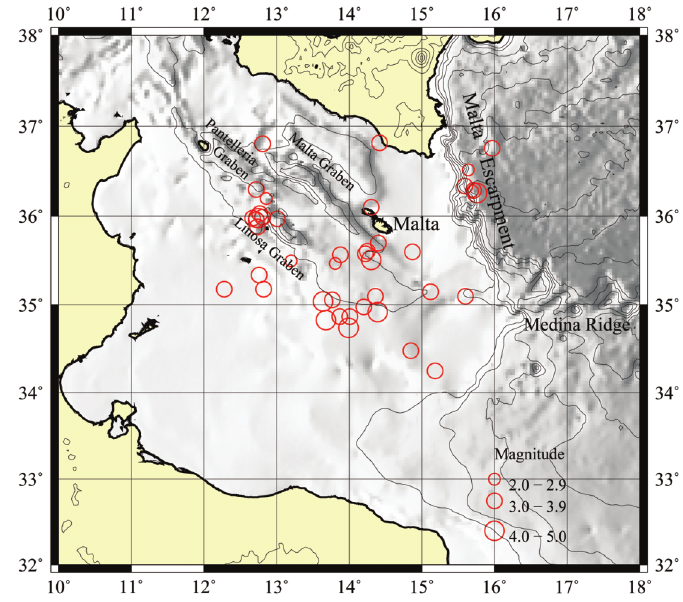
Fig. 3. More reliably located seismicity, 1990-2003 (from Said, 1997; Zammit,